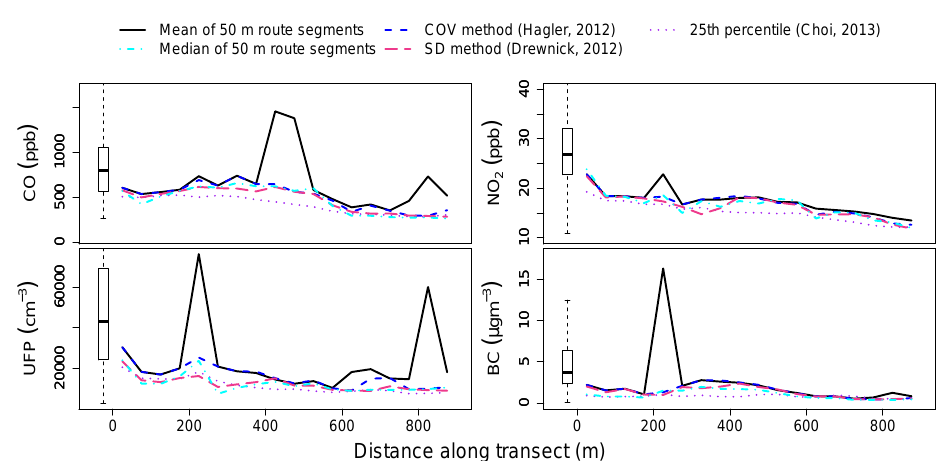
Figure 4. Comparison of the effect of methods of removing the influence of exhaust plumes on transect gradients of CO (a) , UFPs (b) , BC (c) , and NO 2 (d) . Lines represent 50m means (except for the line which represents the medians) of measurements from the entire run (12 laps). Box plots represent unfiltered concentrations measured on the